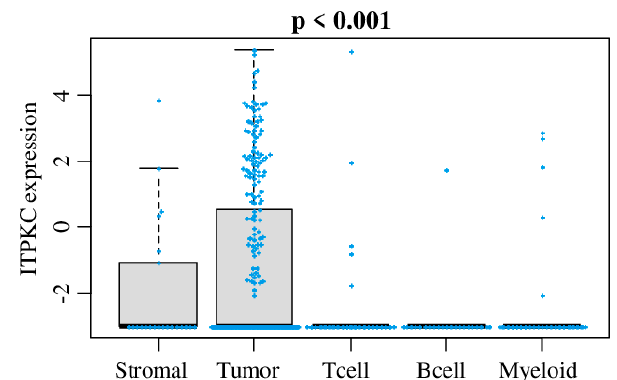
Figure 1. ITPKC gene expression among cells in the tumor microenvironment. Boxplots of the ITPKC gene expression by cancer cells, stromal cells, T cells, B cells and myeloid cells in single-cell sequencing data of primary breast cancer in GSE75688. One-way ANOVA test was used to calculate p values. Tukey-type boxplots show median and inter-quartile level values.